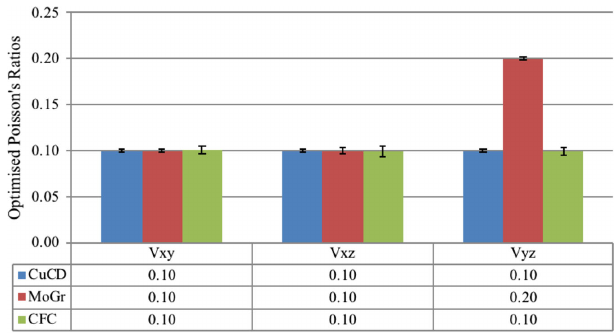
FIG. 24. Optimized elastic Poisson ’ s